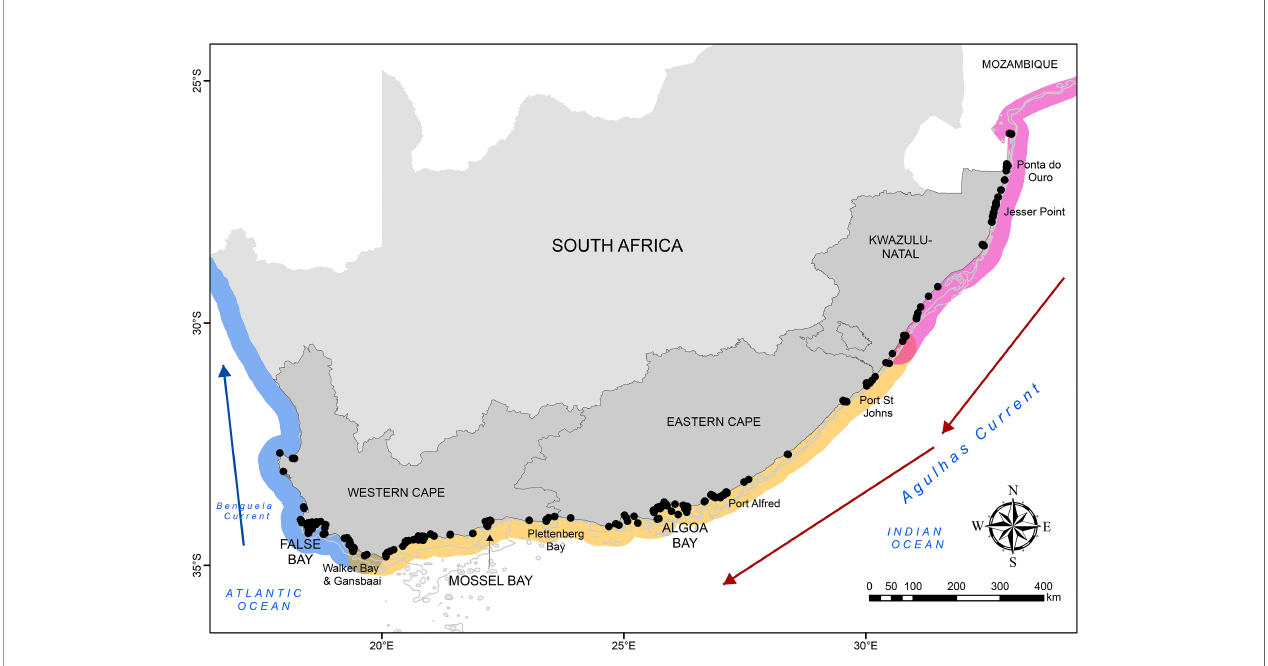
FIGURE 1 | The locations of receivers (black dots) forming the greater Acoustic Tracking Array Platform currently deployed along the South African coastline. In fl uential ocean boundary currents are indicated, as are important sites mentioned in the text. The cool-temperate, warm-temperate and subtropical biogeographic regions are indicated by blue, yellow, and pink areas,